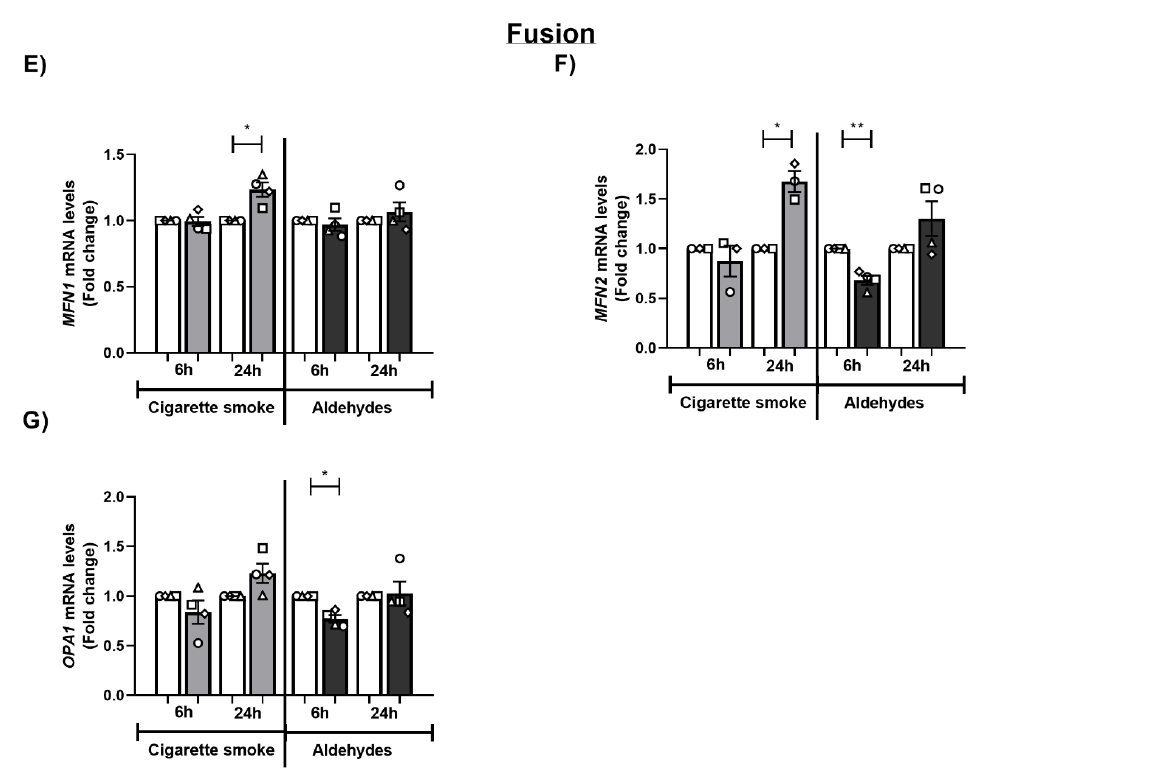
Figure 7. Abundance of mitochondrial fission- and fusion-associated markers is altered after exposure to CS or aldehydes. Differentiated human primary bronchial epithelial cells (PBEC) from non-COPD subjects ( n = 3–4 donors) were exposed to smoke of one Marlboro Red cigarette (CS), or a mixture of acetaldehyde, acrolein, and formaldehyde (at concentrations equivalent to one cigarette), or air (control), under a continuous flow system using a puff-like exposure protocol. After recovery for 6 h or 24 h, whole cell lysates were harvested for analysis of fission-associated markers, ( A , B ) DNM1L protein as well as ( C ) DNM1L and ( D ) FIS1 transcript levels. Representative Western blot images are shown for one replicate from one donor per experiment, reflective of the changes in all donors as quantified in the corresponding graph. In addition, the expression of fusion-associated genes ( E ) MFN1 , ( F ) MFN2 , and ( G ) OPA1 was analyzed. Data are presented as mean fold change compared to air control ± s.e.m. The mean values of biological triplicates for each independent donor are represented by open circles, triangles, squares, or diamonds. Statistical differences between CS vs. air and the mixture of aldehydes vs. air were tested using a two-tailed paired parametric t -test. Statistical significance is indicated as * p < 0.05 and ** p < 0.01 vs. air